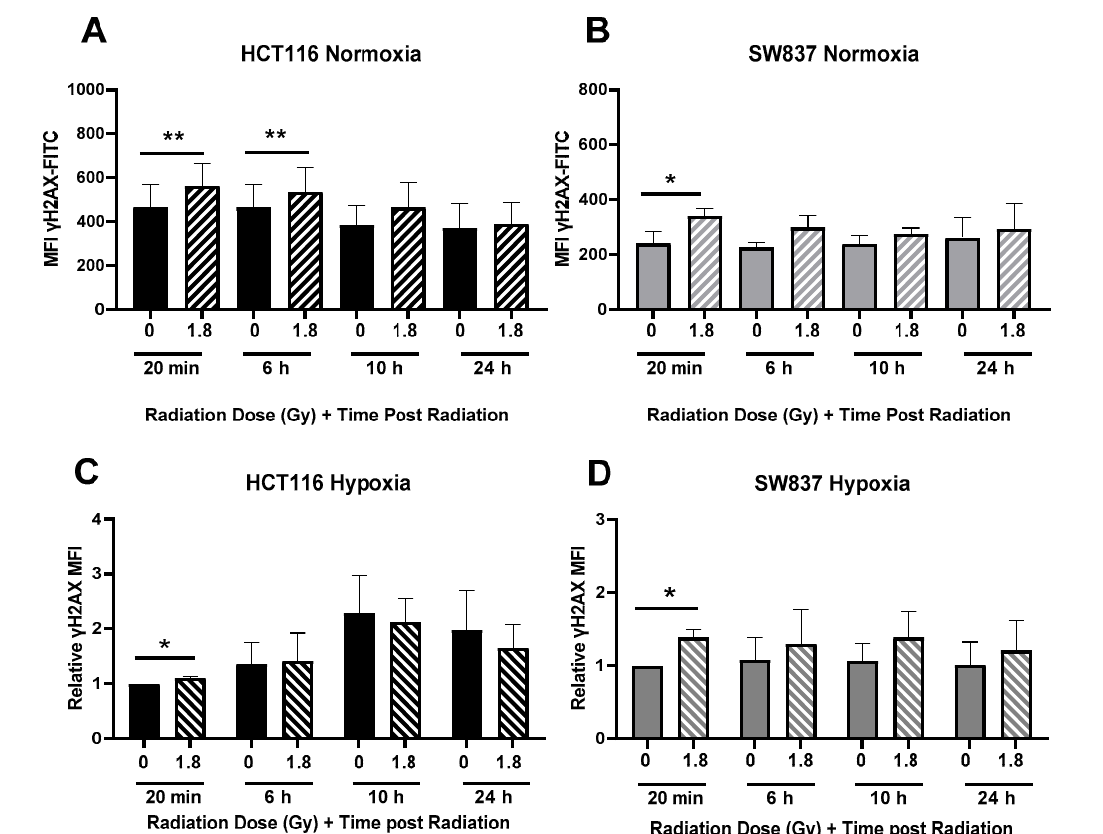
Figure 4. Radiation-induced DNA damage induction and repair in HCT116 and SW837 cells. HCT116 and SW837 cells were irradiated with 1.8 Gy X-ray radiation, and DNA damage was assessed at 20 min, 6 h, 10 h and 24 h post-radiation under normoxia by γ H 2 AX fluorescence and flow cytometry. ( A ) DNA damage levels in HCT116 cells following radiation, under normoxic conditions, and ( B ) DNA damage levels in SW837 cells following radiation, under normoxic conditions. HCT116 and SW837 cells were exposed to hypoxia for 24 h prior to irradiation with 1.8 Gy, and DNA damage was assessed at 20 min, 6 h, 10 h and 24 h post-radiation exposure by γ H 2 AX fluorescence and flow cytometry. ( C ) DNA damage levels in HCT116 following radiation, under hypoxic conditions. ( D ) DNA damage levels in SW837 cells following radiation, under hypoxic conditions. Data are presented as absolute or relative mean fluorescent intensities (MFIs) ± SEMs for four independent experiments. Statistical analysis was performed by paired t -testing. * p < 0.05, ** p < 0.01.